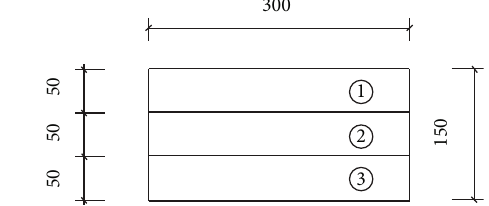
Figure 1: Specimen dimension for a series of